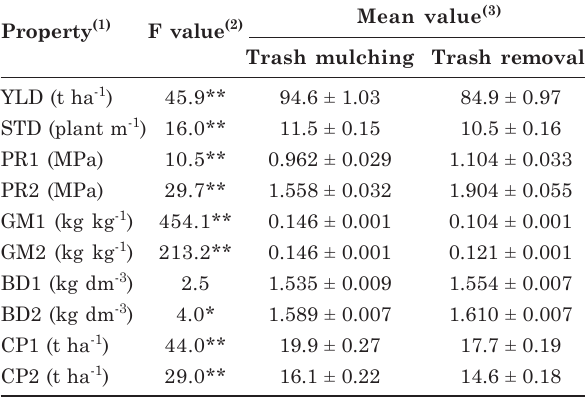
(1) YLD, STD, PR, GM, BD, and CP are, respectively, the stalk yield per hectare, stand density, penetration resistance, gravimetric moisture, bulk density, and carbon pool in the soil in the layers 0.0-0.20 (1) and 0.20-0.40 m (2); (2) * and **: significant at 5 and 1 %, respectively; (3) Mean values ± mean standard